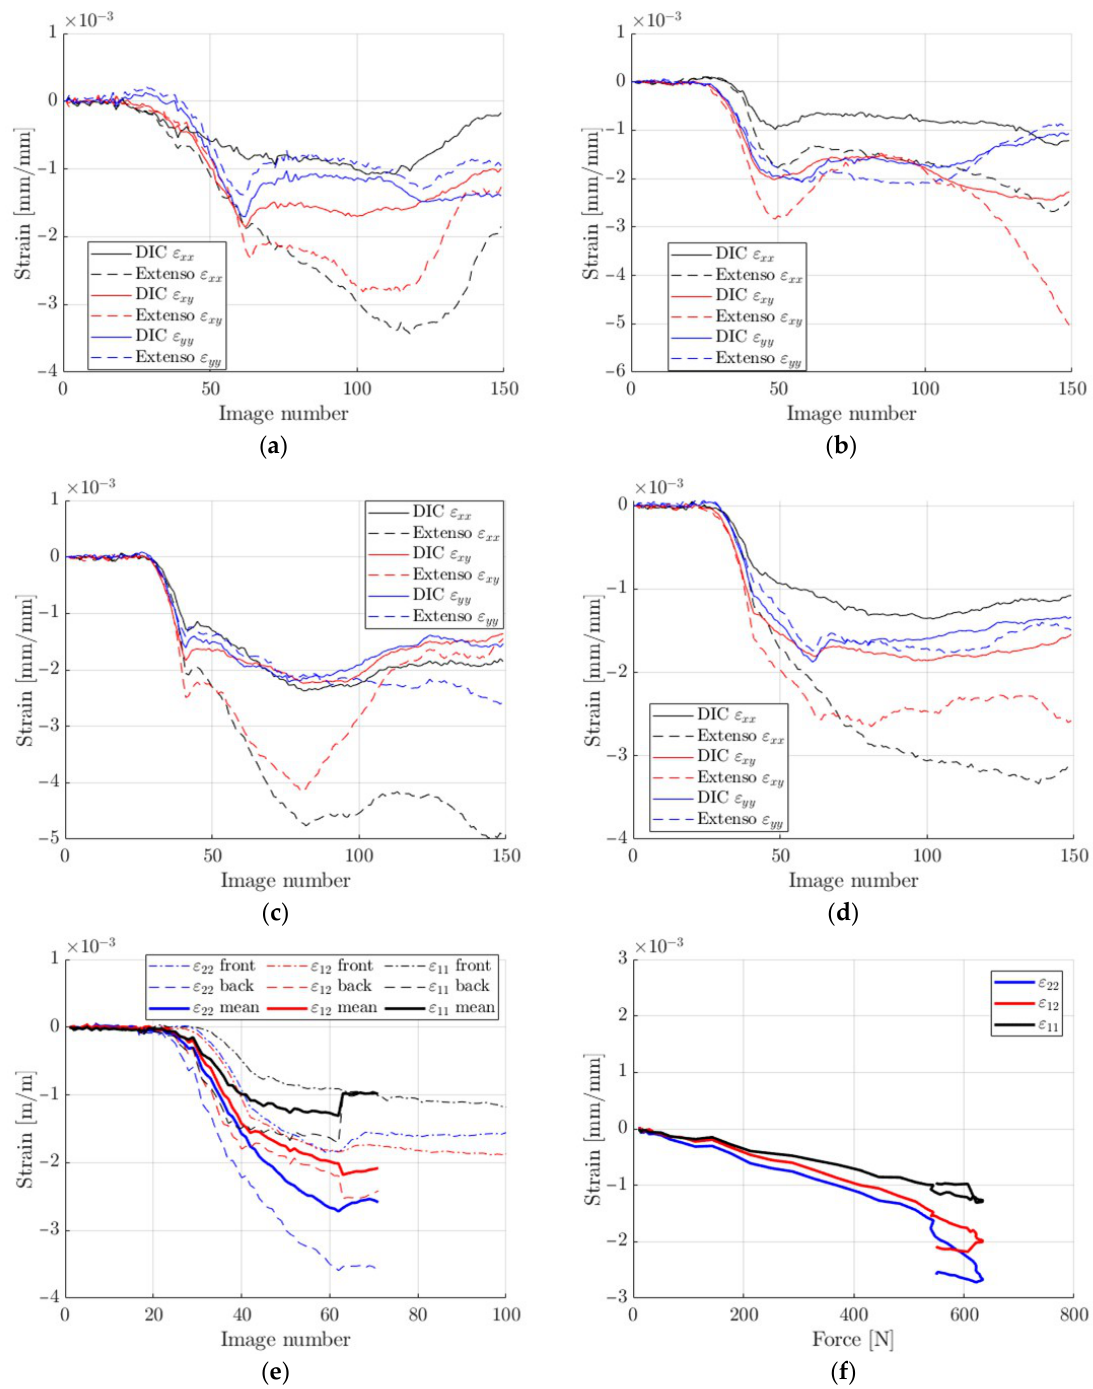
Figure 10. DIC vs. virtual extensometry comparison: ( a ) region 1; ( b ) region 2; ( c ) region 3; ( d ) mean from 3 regions; ( e ) back-to-front average; ( f ) strains resulting from forces.